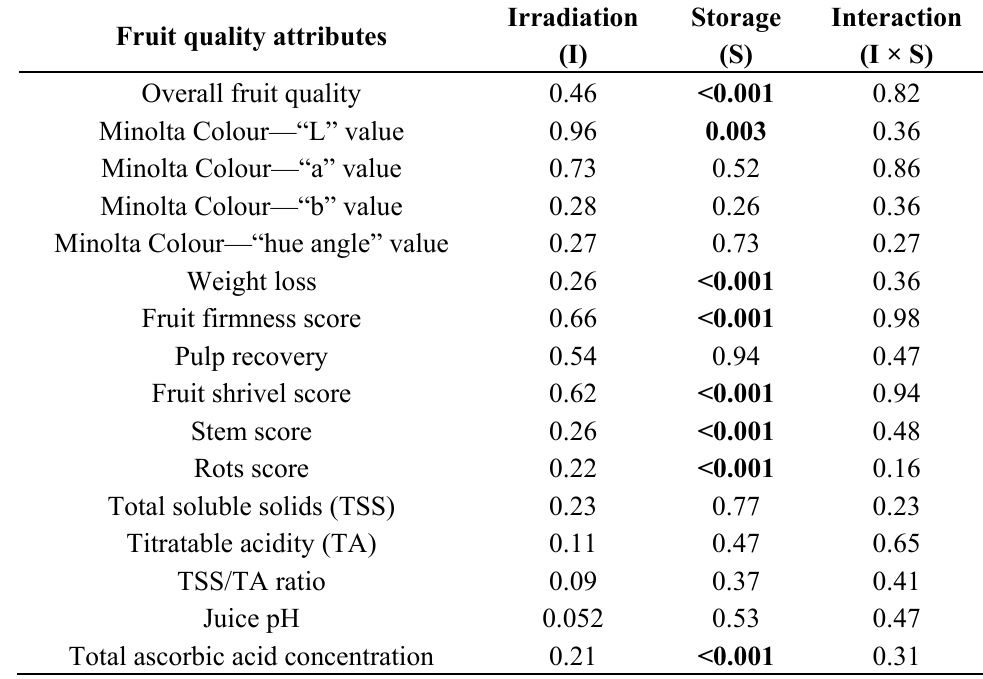
Table 2. p values for the effects of irradiation, storage and the interaction of irradiation and storage treatments on fruit quality attributes and total ascorbic acid concentration. Effects with p values <0.05 (in bold) were statistically significant at the 5%